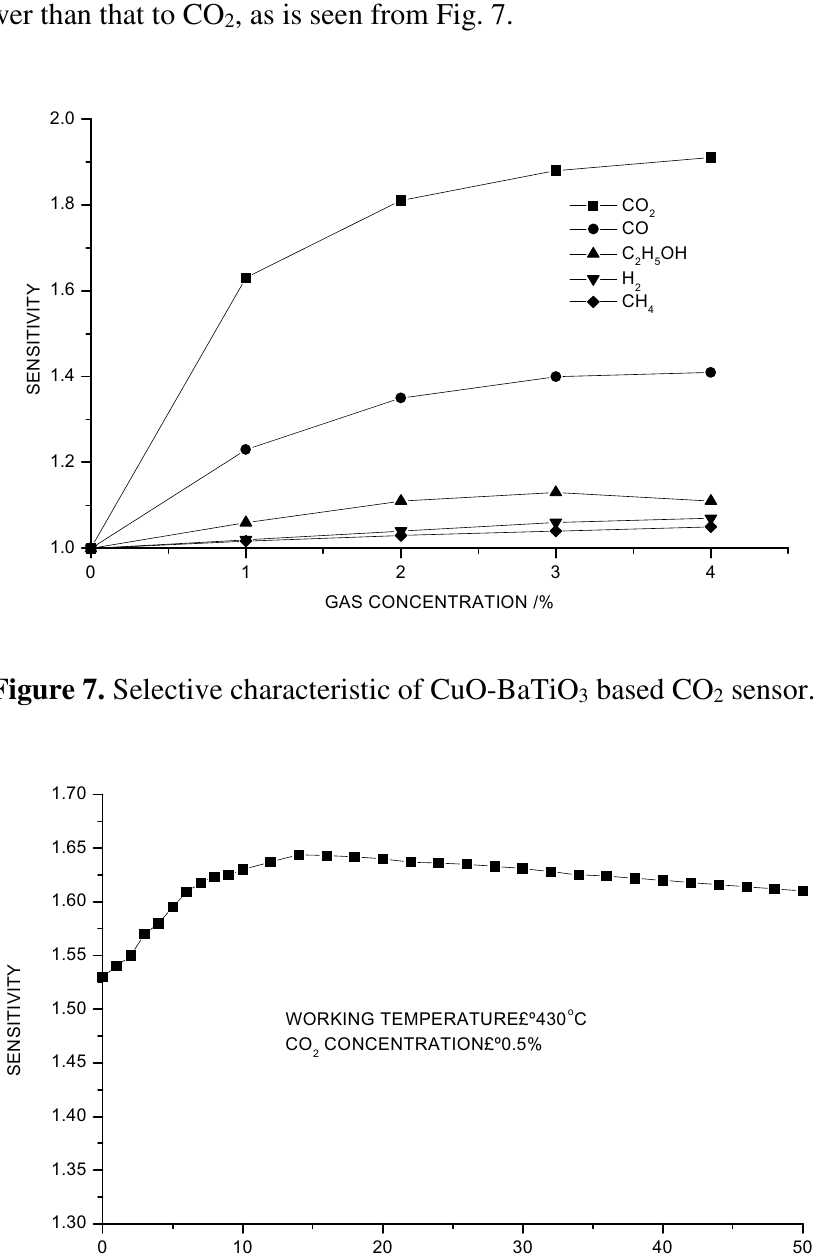
based CO sensor over 3 2